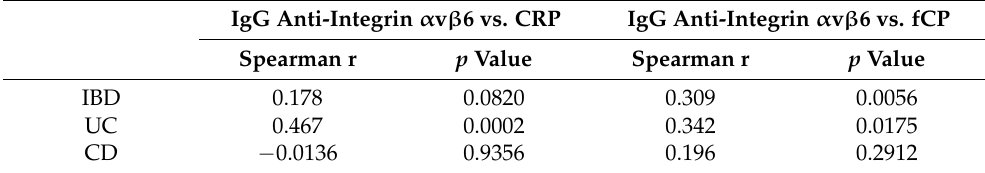
Table 3. Correlation between IgG anti-integrin α v β 6 autoantibodies and C-reactive protein and faecal